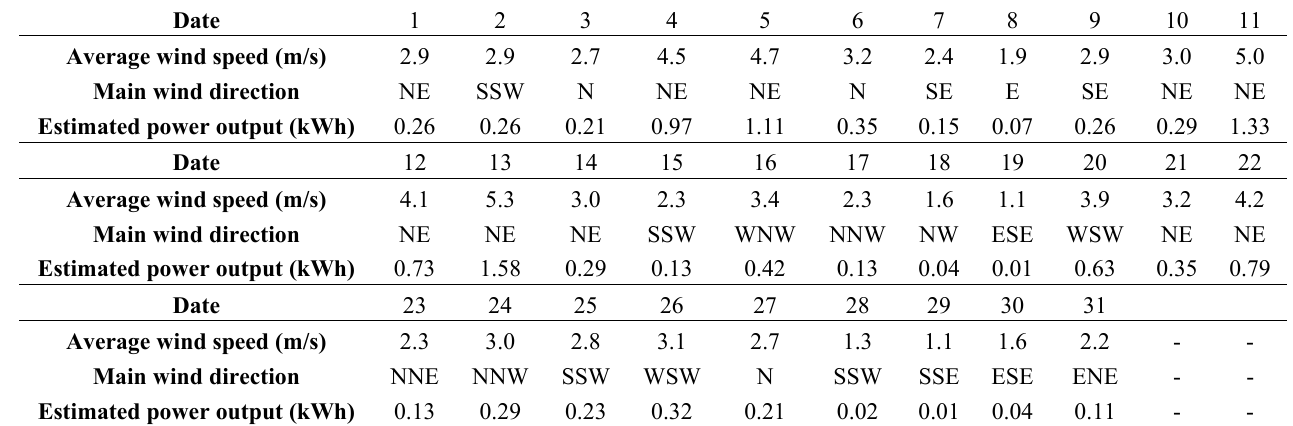
Table A10. Estimated power output per day in October.